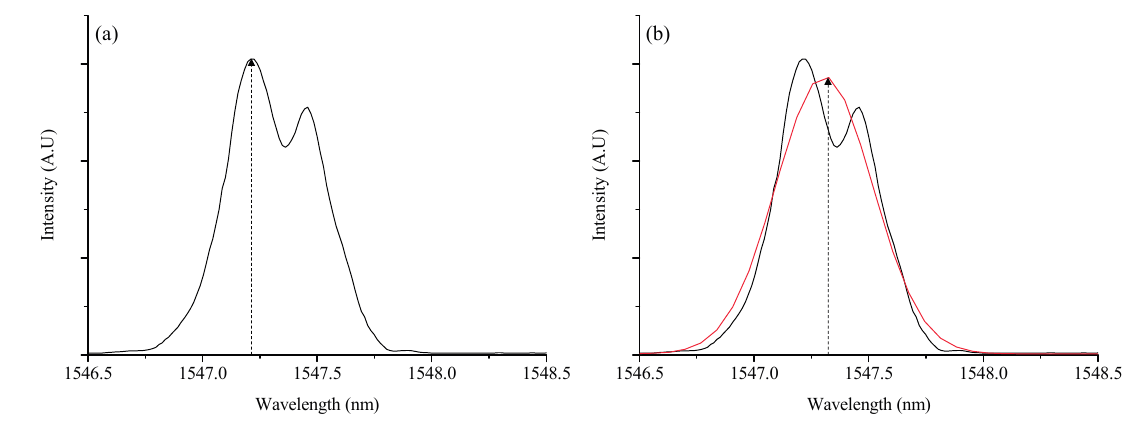
Figure 9. Center positioning of FBG sensor spectrum (( a ): Without Gaussian curve fitting, ( b ): With Gaussian curve